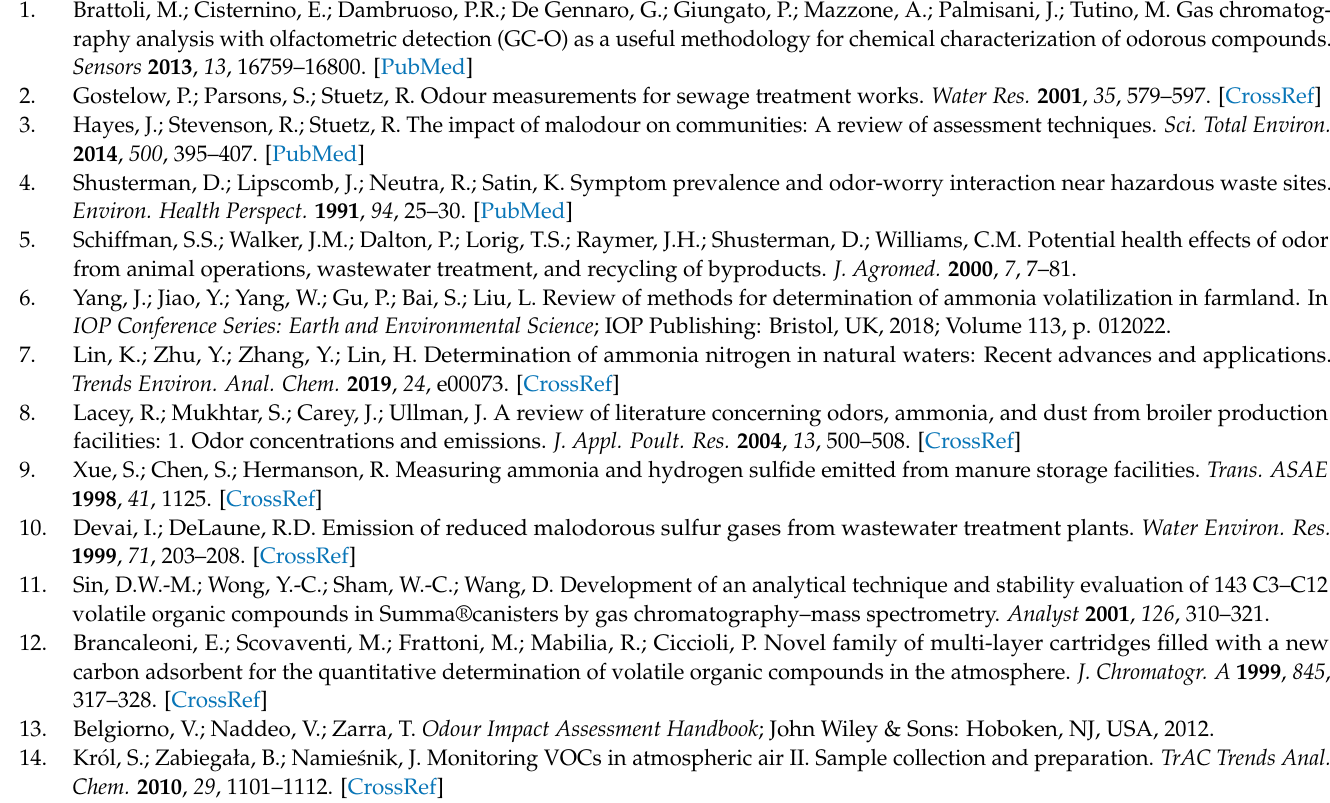
Table S1: Quality assurance of the S-Tube and M-Tube sampling for 42 target compounds; Table S2: Mass of adsorbents (Tenax ® TA, Carbopack™ B, and Carboxen ® 1003) packed in multi-sorbent tubes; Table S3: Characteristics of adsorbents used in this study; Table S4: Capture efficiency (%) of specified VOCs by sorbent tubes on gas sampling flow rates; Table S5: Relative recovery rates between different standard phases (gas and liquid) in the analysis of VOCs using gas chromatography-mass spectrometry (Am: chromatographic peak area of gas samples in the multi-sorbent tube method, As: chromatographic peak area of gas samples in the single-sorbent tube method, Al: chromatographic peak area of liquid